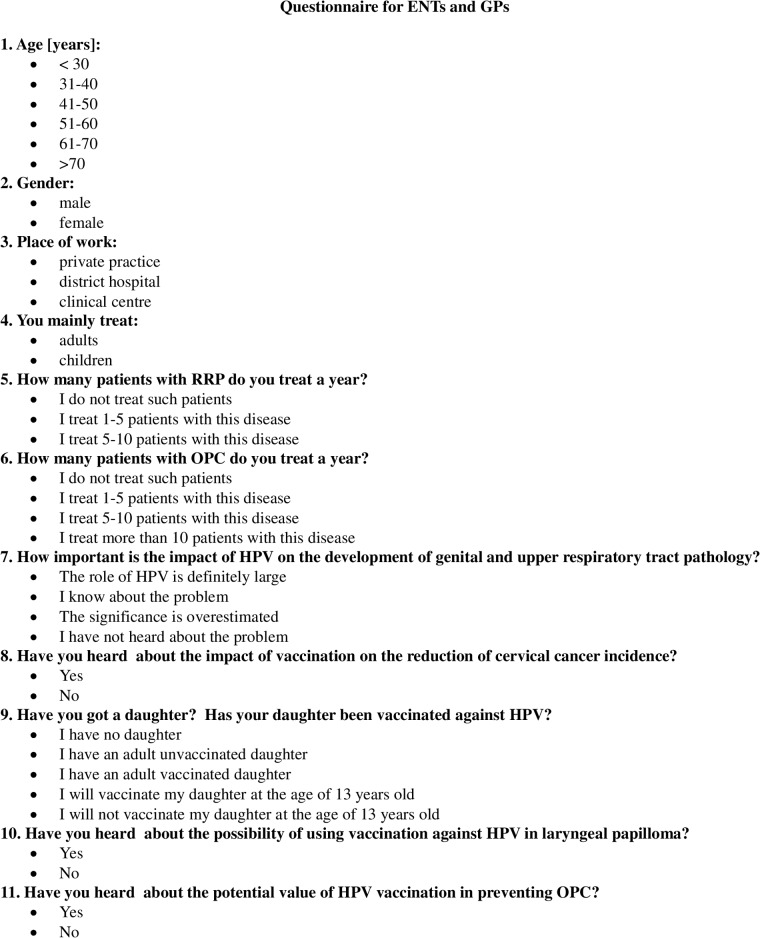
Questionnaire for ENTs and GPs.